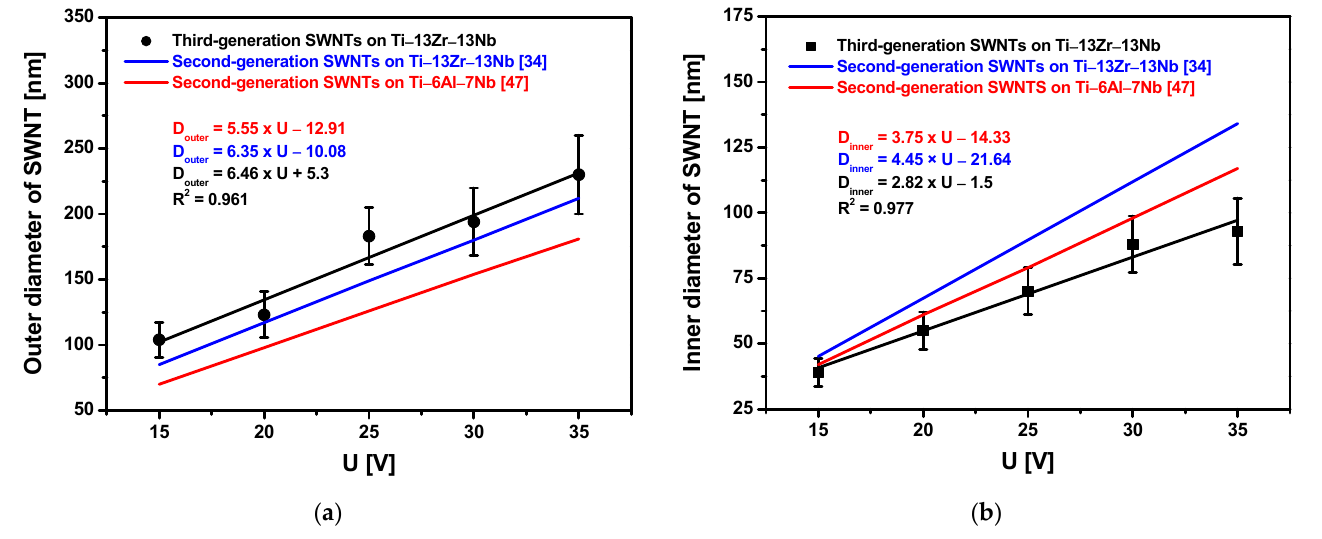
Figure 5. The oxide nanotube diameter on the Ti-13Zr-13Nb alloy surface as a function of anodizing voltage (U) for 120 min in 1 M C 2 H 6 O 2 + 4 wt% NH 4 F electrolyte: ( a ) Outer diameter (D outer ); ( b ) Inner diameter (D i ).